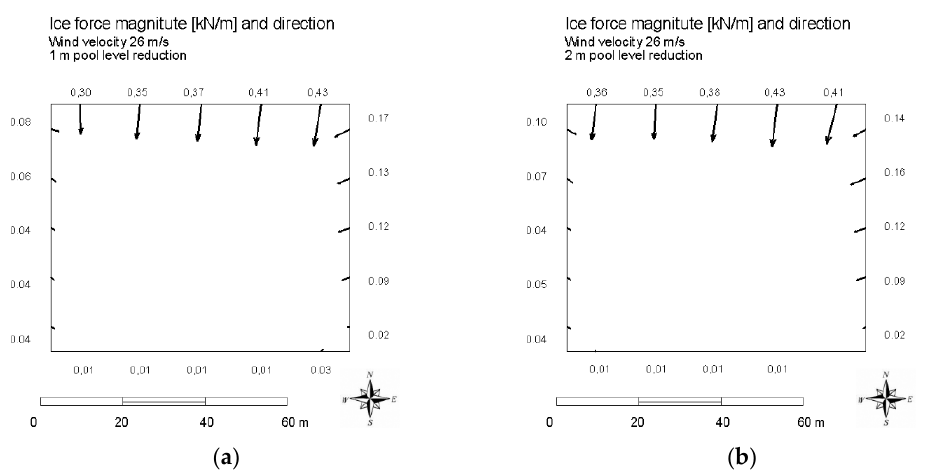
Figure 9. Magnitude and direction of the force vectors placed on the structure edges for ( a ) 26 m/s wind velocity with 1 m and ( b ) 2 m pool level reduction. Figure 10 indicates the maximum normal and tangential forces imposed on the struc-